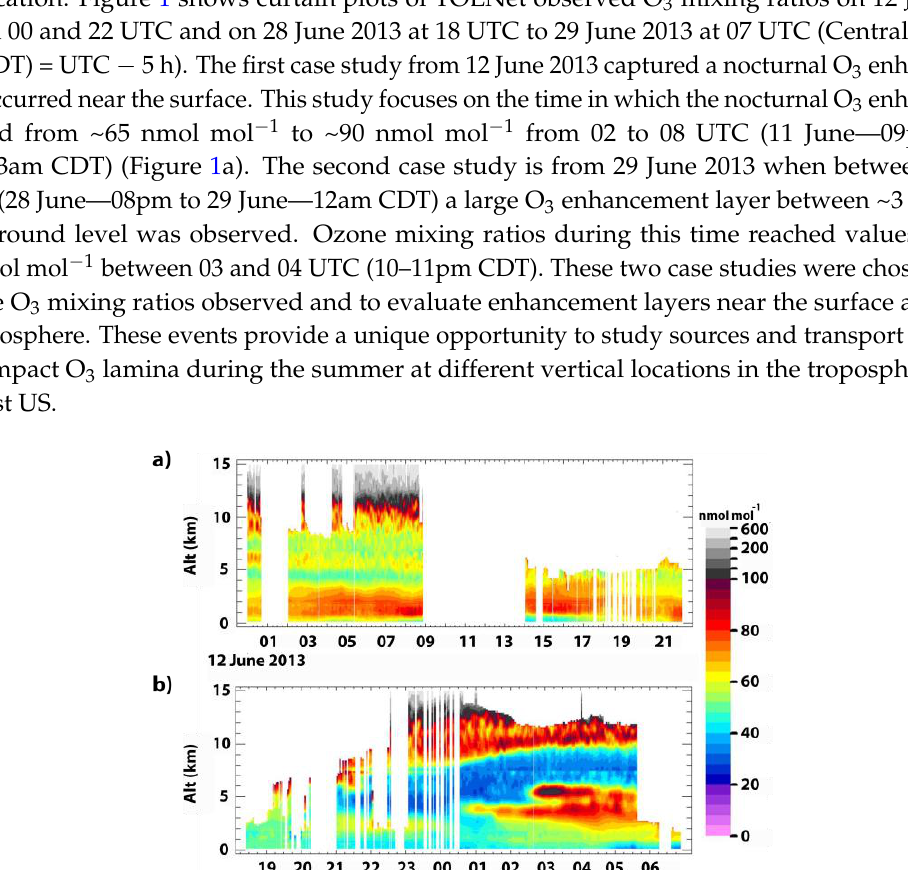
Figure 1. UAH TOLNet observations of O 3 (nmol mol −1 ) on ( a ) 12 June 2013 and ( b ) 28–29 June 2013.